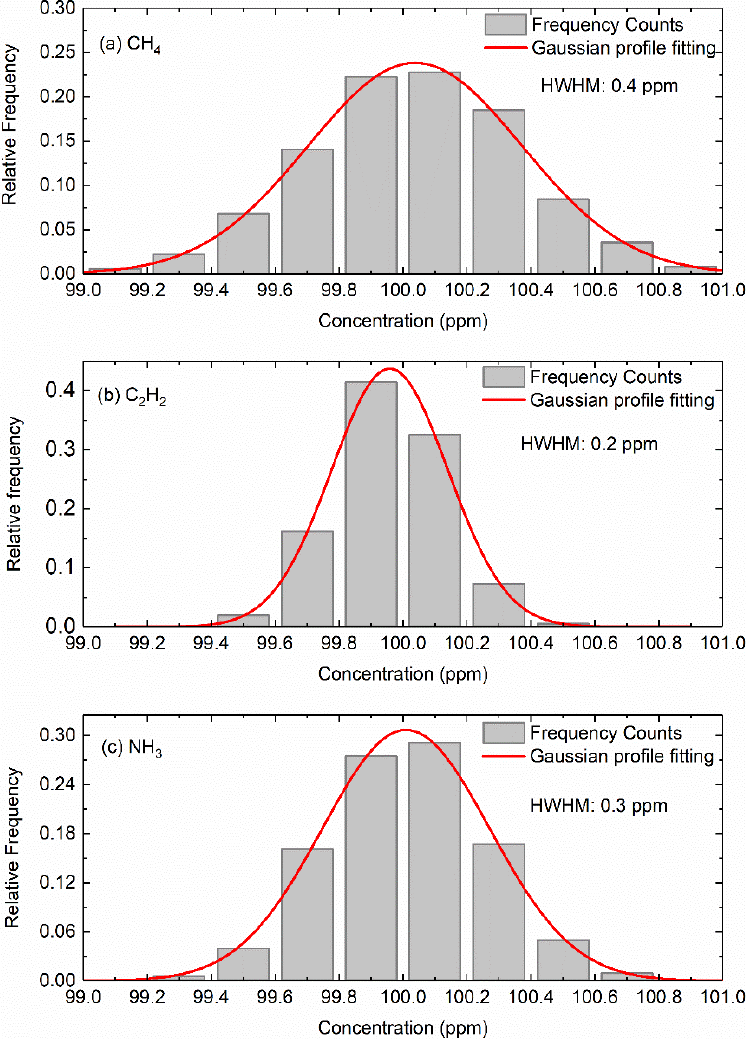
Figure 7. Frequency distribution of the measured data along with the Gaussian function fitting based on the time-resolved measurements of 100 ppm CH 4 ( a ), 100 ppm C 2 H 2 ( b ) and 100 ppm NH 3 ( c ) in the multipass gas cell.